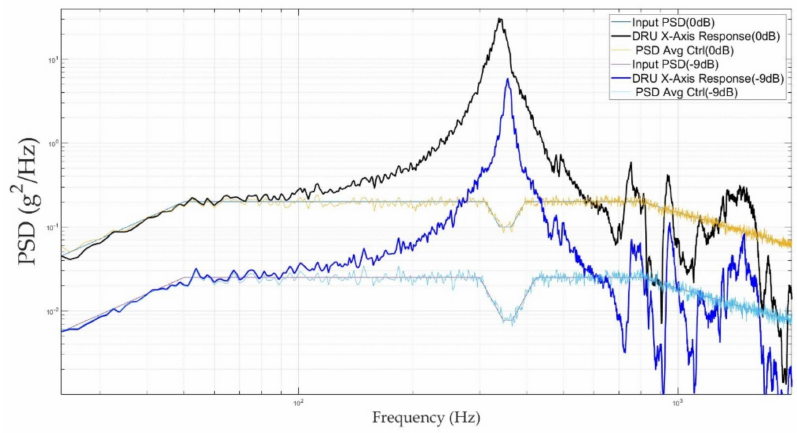
Figure 15. Random vibration test results 0 dB and − 9 dB of HSDRU.